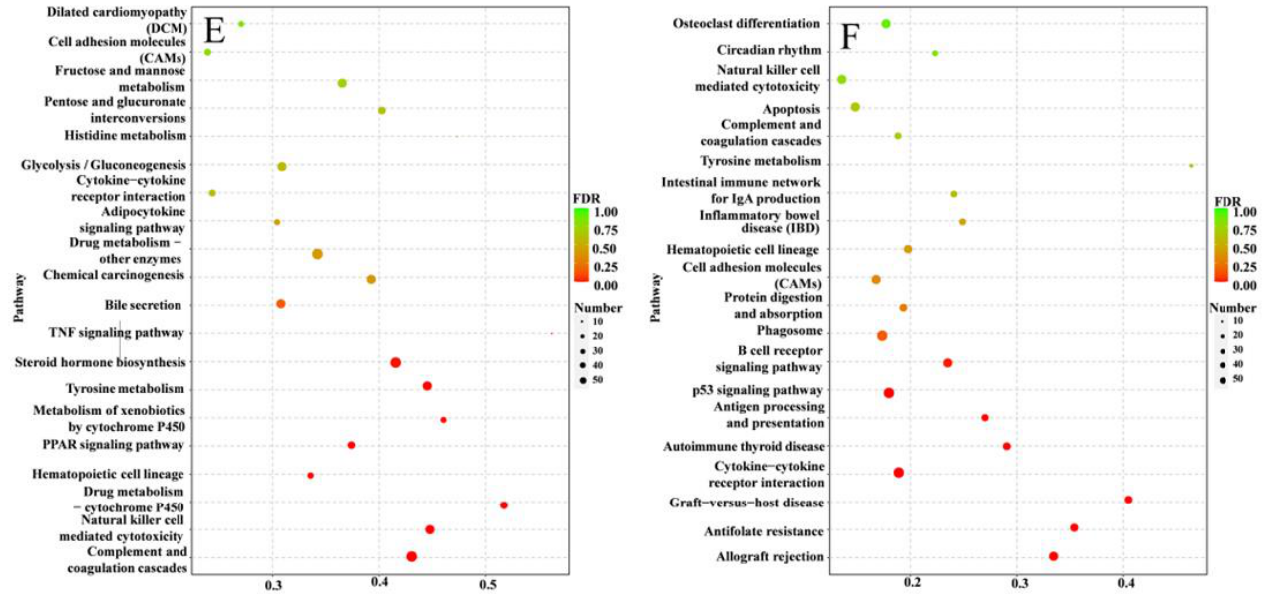
Figure 2. Bubble chart of KEGG pathway enrichment of DEGs in the ( A ) liver, 48 h vs. 0 h; ( B ) liver, 120 h vs. 0 h; ( C ) spleen, 48 h vs. 0 h; ( D ) spleen, 120 h vs. 0 h; and ( E ) head kidney, 48 h vs. 0 h and ( F ) 120 h vs. 0 h. The vertical axis represents the pathway categories, and the horizontal axis shows the DEG ratio. The point size shows the number of DEGs enriched in the KEGG pathway. The point color shows different Q values, as indicated on the right.